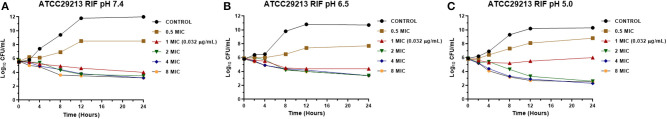
Time-kill curve for rifaximin on Staphylococcus aureus ATCC 29213 at pH 7.4 (A), 6.5 (B), and 5.0 (C) [minimum inhibitory concentration (MIC) = 0.032 μg/mL].